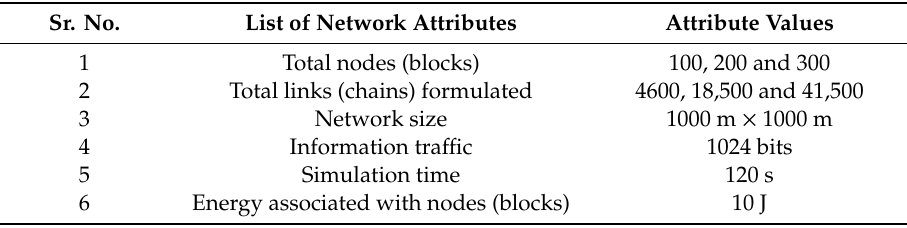
Table 2. Network parameters used in MATLAB Simulink for the experiment. Sr.